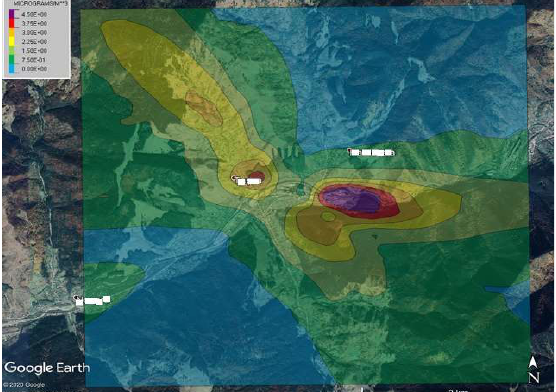
Figure 19. Daily SO 2 concentration in the area of interest—Google Earth Pro .